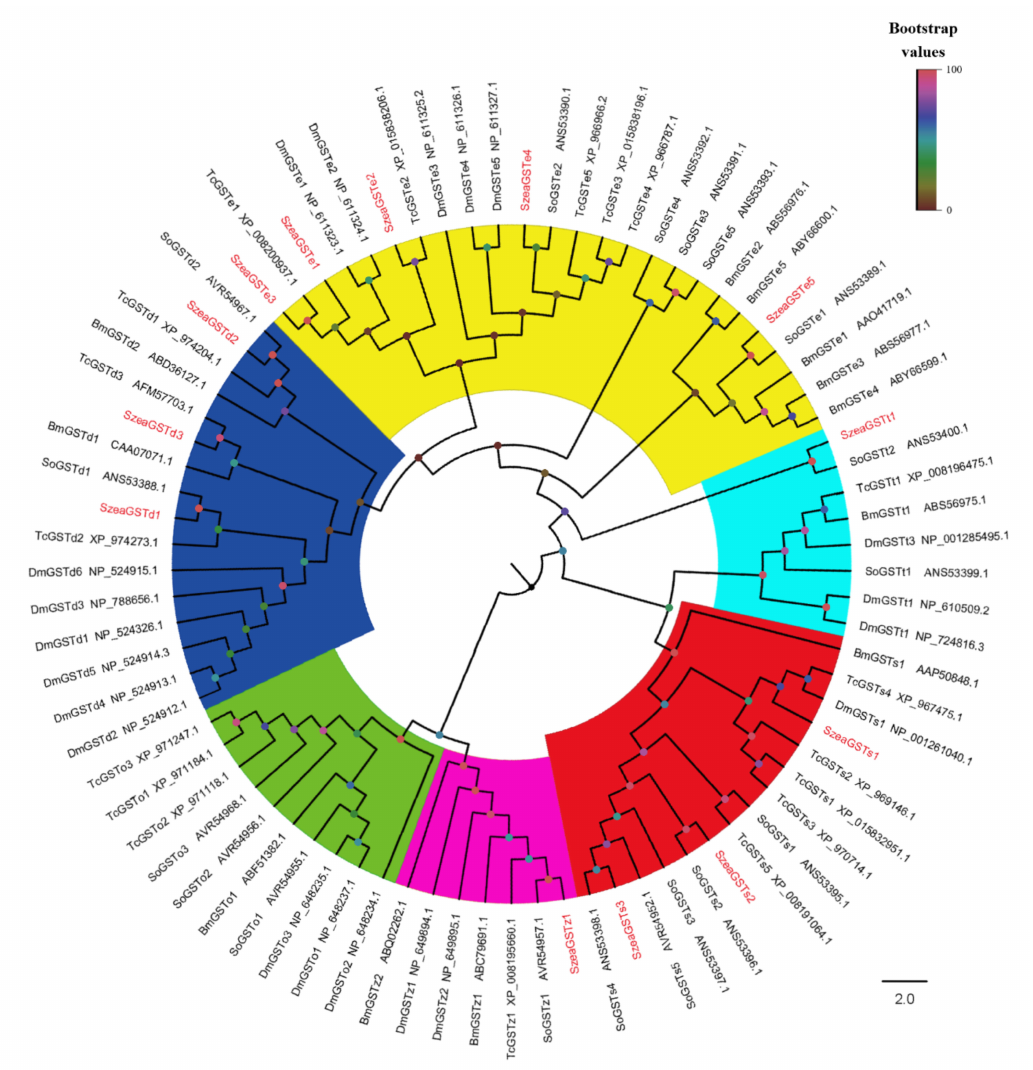
Figure 1. Phylogenetic analysis of SzeaGSTs with GSTs of other insects. The GST family is shown in different colors: blue: Delta; red: Sigma; yellow: Epsilon; green: Omega; sky blue: Theta; purple: Zeta; So: Sitophilus oryzae ; Tc: Tribolium castaneum ; Dm: Drosophila melanogaster ; Bm: Bombyx mori